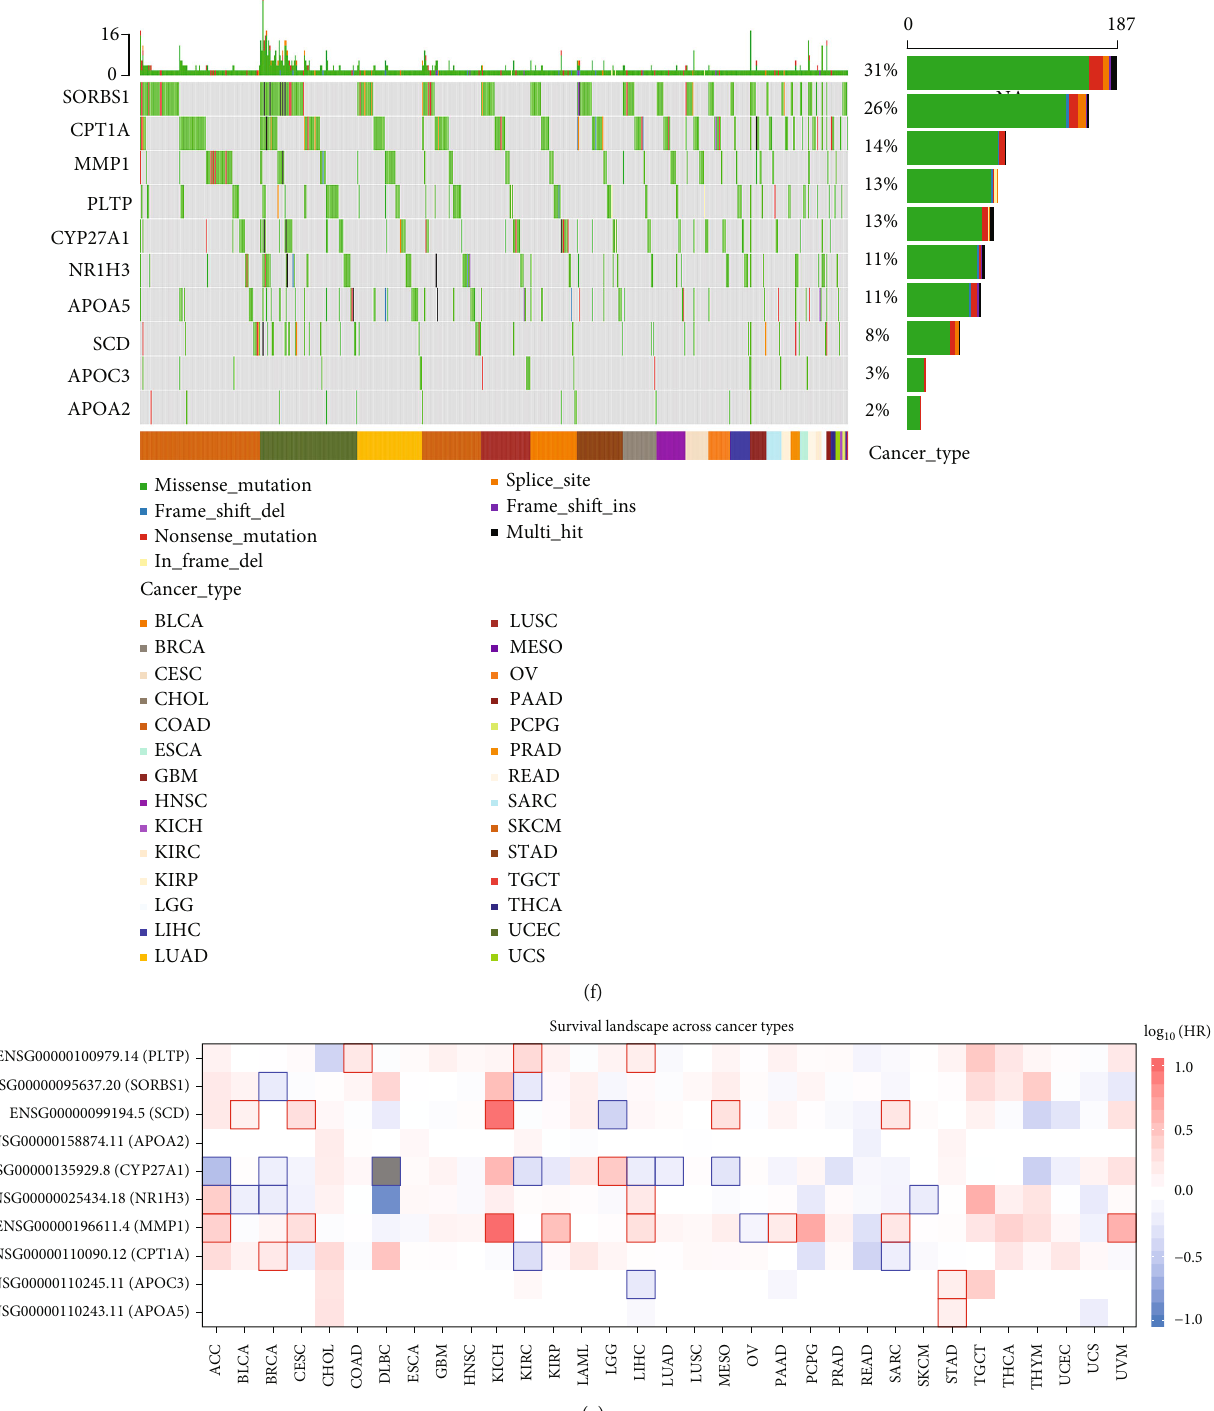
APOA2APOC3SCDAPOA5NR1H3CYP27A1PLTPMMP1CPT1ASORBS1